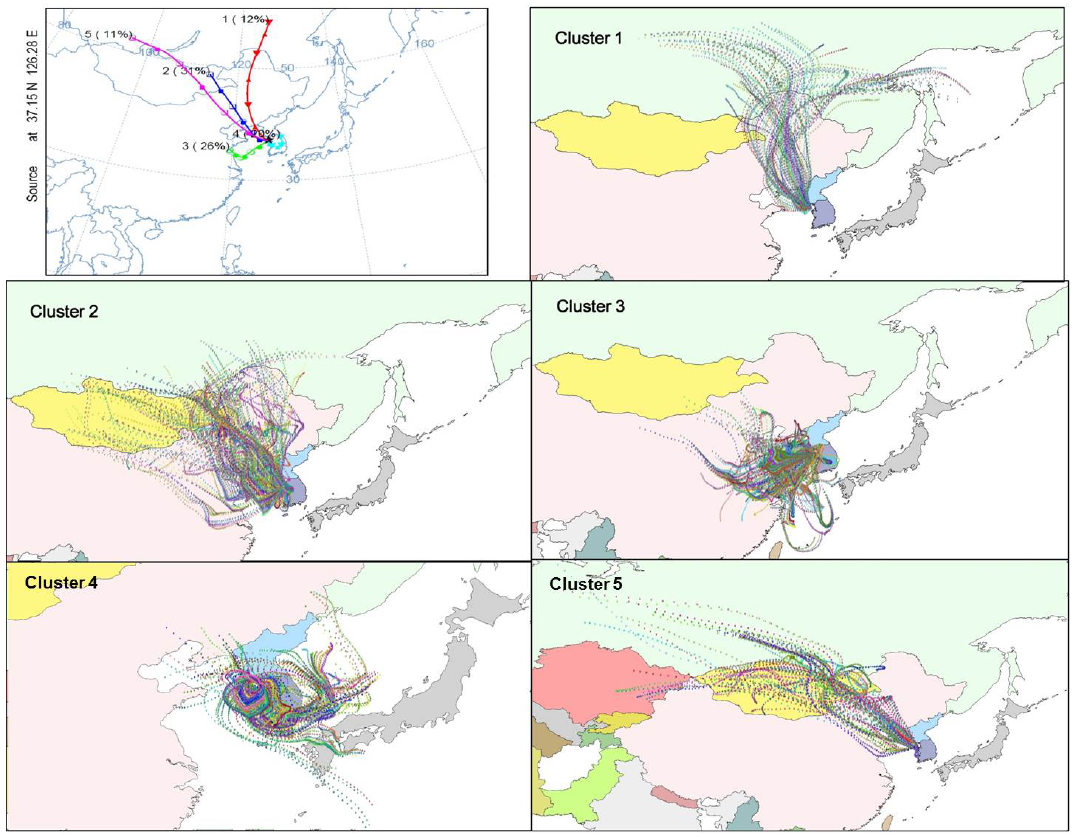
Figure 8. Back trajectories for clusters 1 through 5. The left top panel indicates the mean back trajectory and contribution for each cluster.